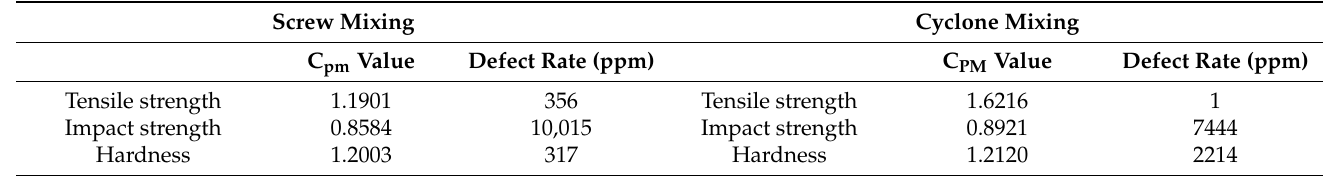
Table 13. Process defect rate.